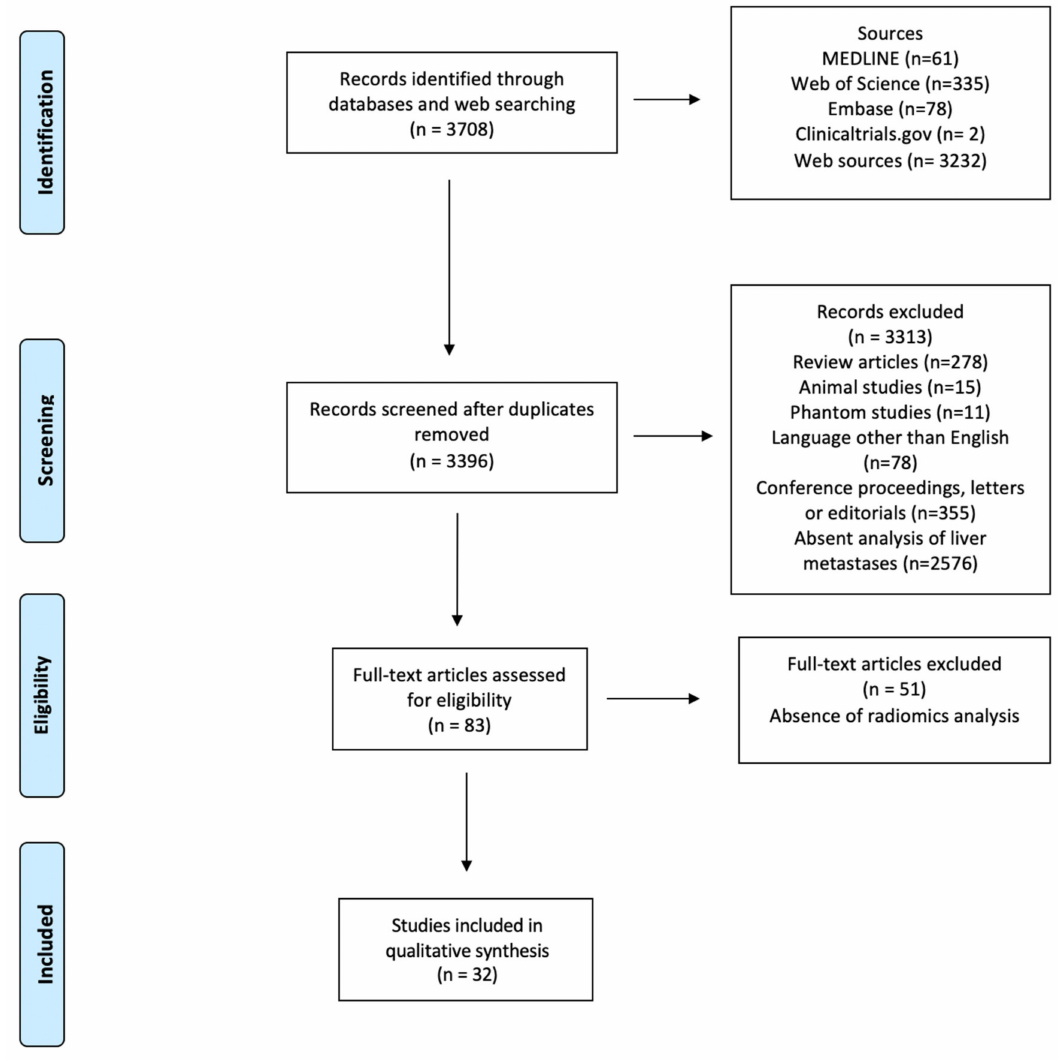
Figure 1. PRISMA Flowchart of study